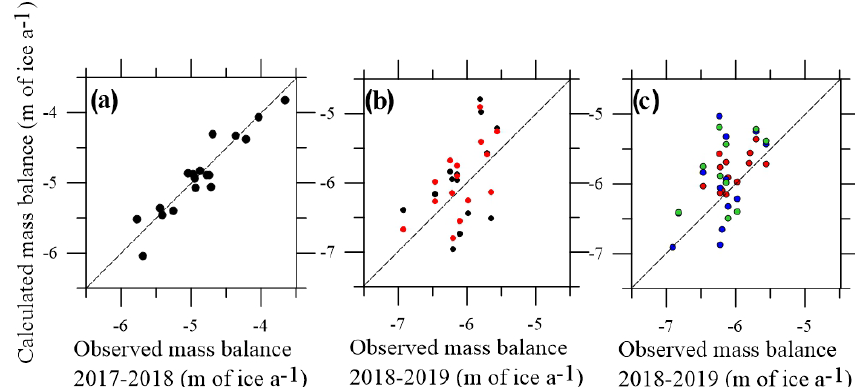
Figure 8. Observed and calculated point surface mass balances at 2350ma.s.l. at Argentière Glacier. The point surface mass balances have been calculated (a) for the year 2017/2018 using the vertical velocities measured in 2016/2017 and elevations from GNSS measurements, (b) for the year 2018/2019 using the vertical velocities measured in 2016/2017 (black dots) and 2017/2018 (red dots) and elevations from GNSS measurements and (c) for the year 2018/2019 using elevations from remote sensing data (UAV data) and the vertical velocities measured in 2018/2019 (red dots), 2017/2018 (blue dots) and 2016/2017 (green dots). The large dots shown in Fig. 8b correspond to the stakes which were set up within a radius of less than